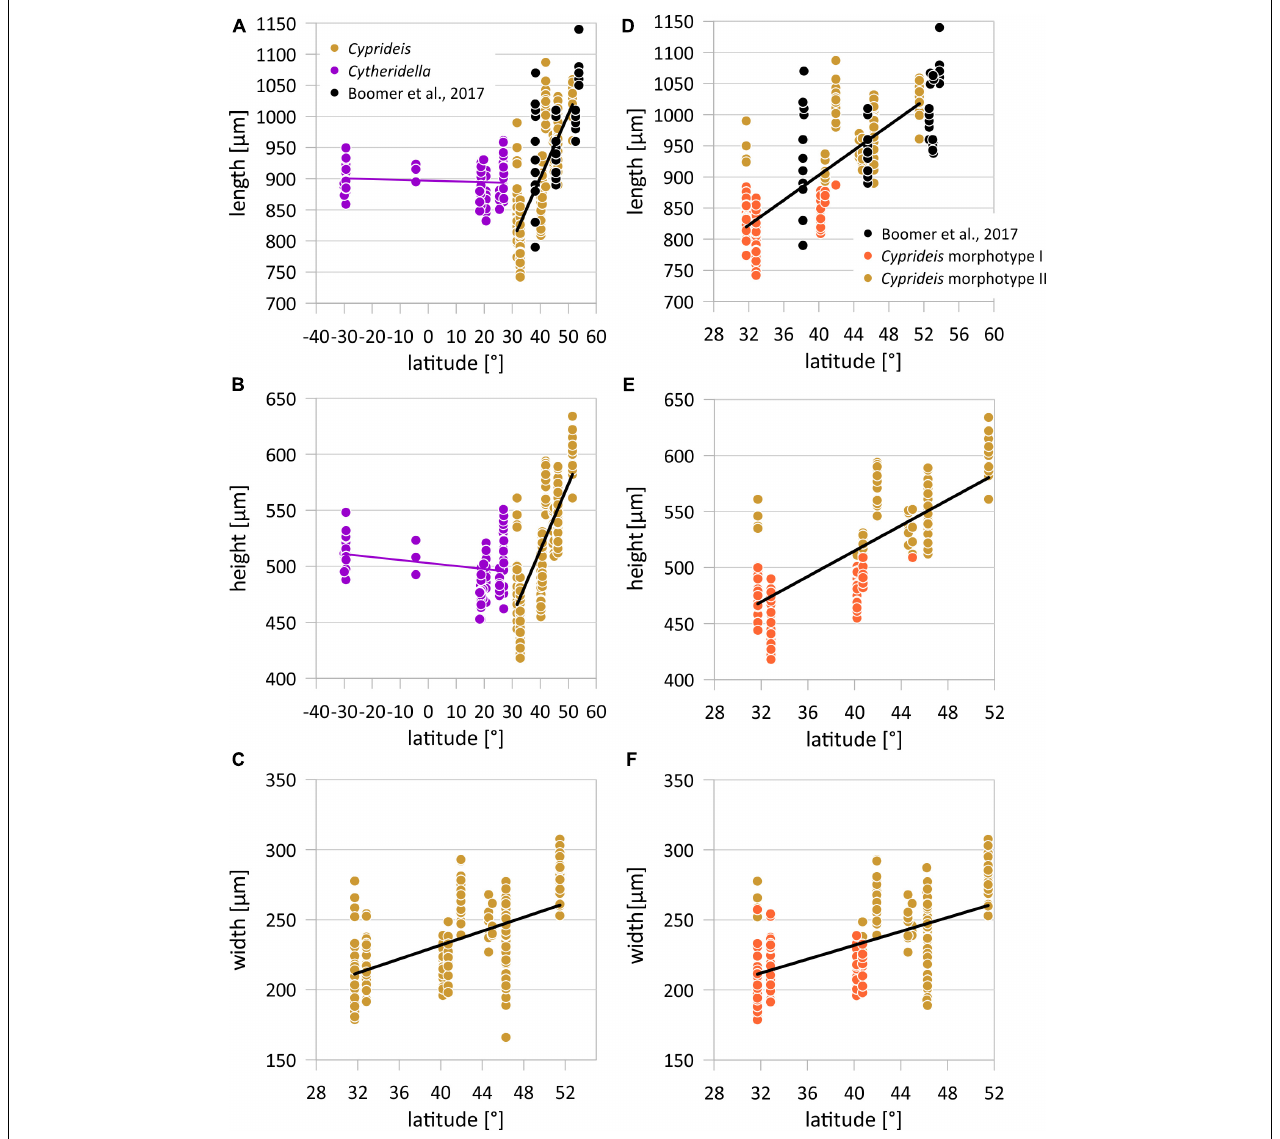
FIGURE 5 | Latitudinal variation of valve length, height, and width of Cyprideis torosa and length and height of Cytheridella ilosvayi (A–C) . Latitudinal distribution of Cyprideis size traits differentiated for morphotype I and II (D–F)